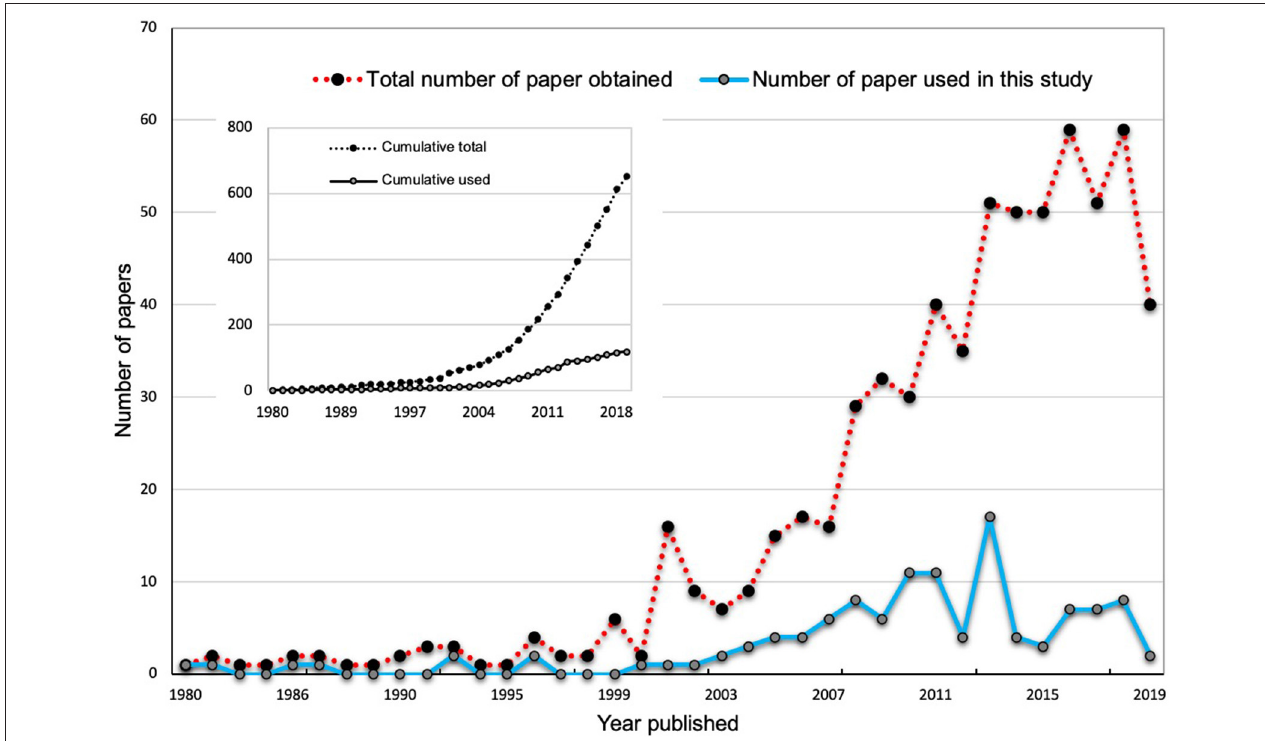
FIGURE 1 | The total number of publications about mycorrhizal effects on plant salinity stress physiology available in the “SCOPUS” and “Web of Science” databases from 1980 to 2019. The inlets in the main plots show the total number of publications found in the search, while the main plots show the number of articles by year.